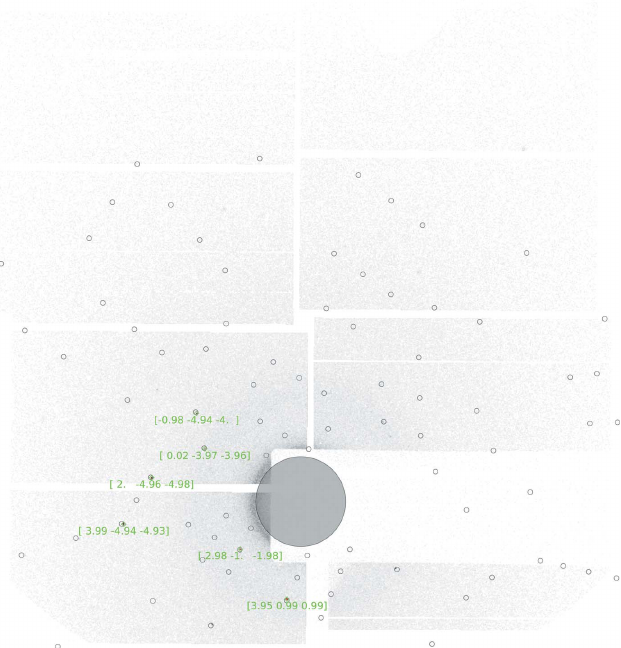
Figure 5 Indexing of the initially found spots on Data Frame 1. Diffraction spots from one crystal have been identified and the orientation matrix determined. Note that all assigned hkl values are close to integer numbers (the pre-set tolerance was 0.15). Rejected spots would be enclosed in red squares, but no spots have been rejected on Data Frame 1 during the indexing